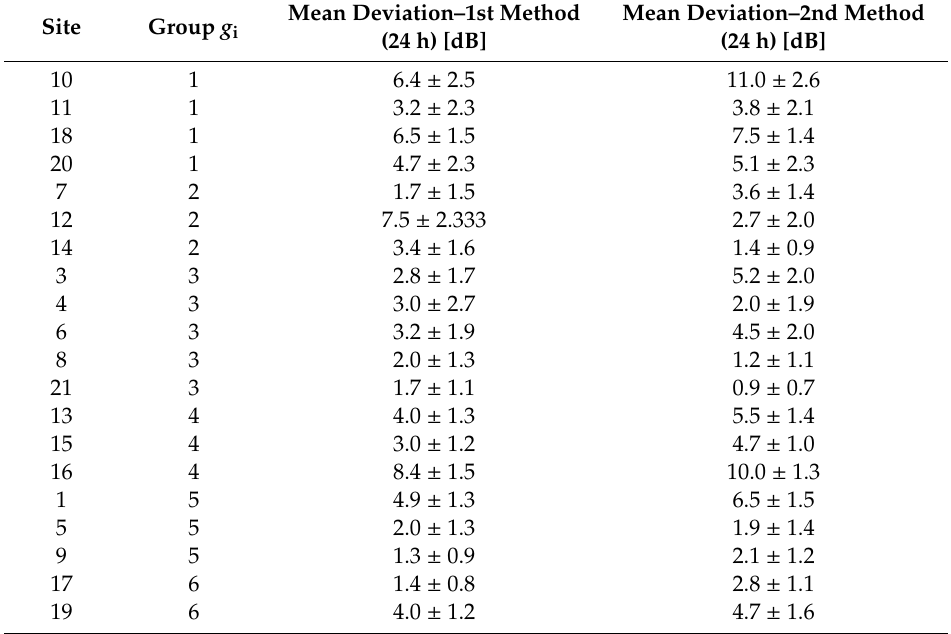
Table 7. Summary of the total daily mean deviation (24 h) for the two prediction methods in all the 21 test